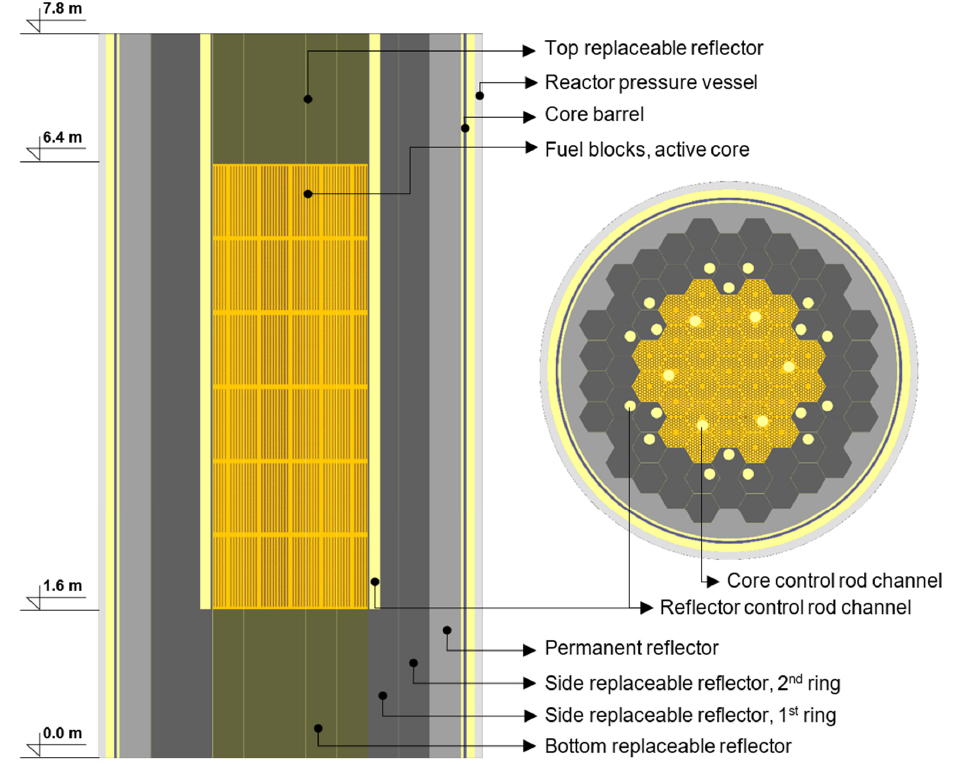
Figure 2. TeResa core configuration, Serpent model visualization.